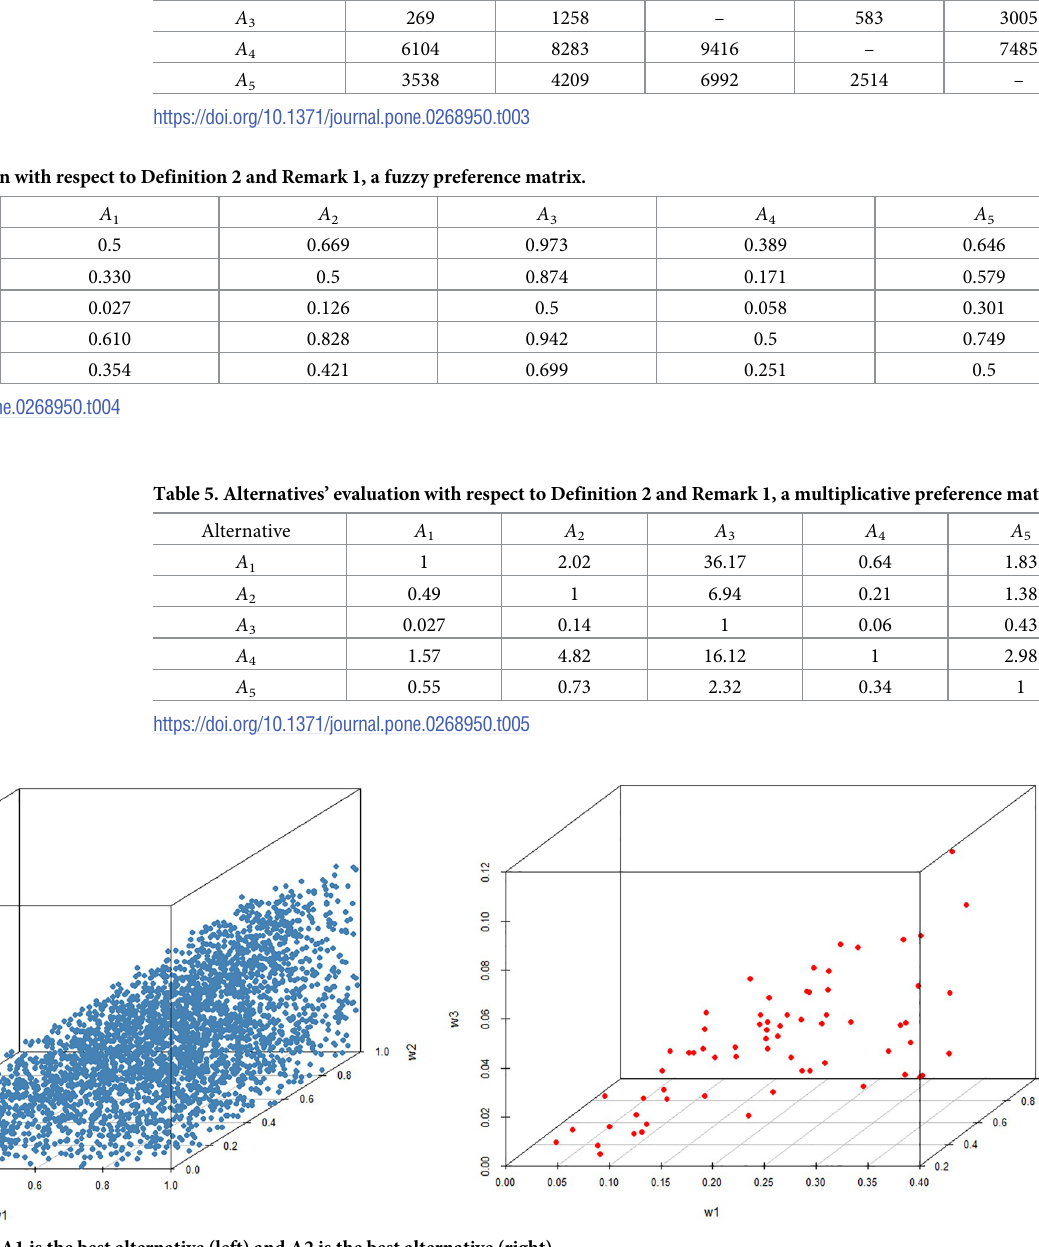
Fig 2. Weights of criteria if A1 is the best alternative (left) and A2 is the best alternative